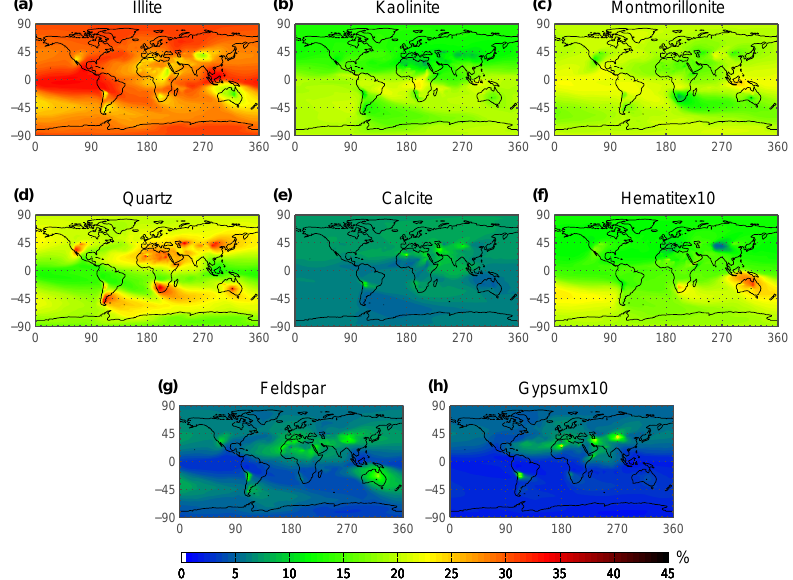
Figure 2. Total percent column mineral distributions for CAM4 shown as the sum of all four bins for each mineral. Hematite (f) and gypsum (h) are scaled by 10 so that they can be visually compared with illite (a) , kaolinite (b) , montmorillonite (c) , quartz (d) , calcite (e) and feldspar (g) .